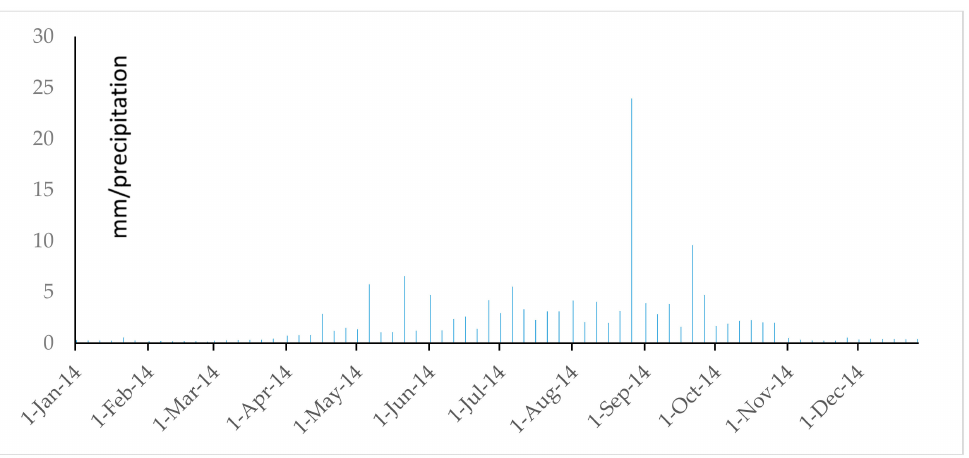
Figure A42. Precipitation of Denko County in